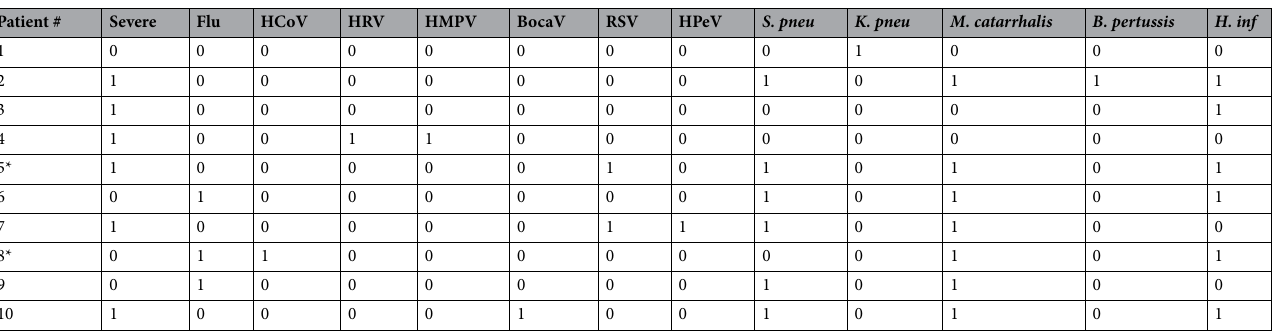
Table 4. Organisms detected in nasopharynx in children who met the WHO pneumonia definition 19